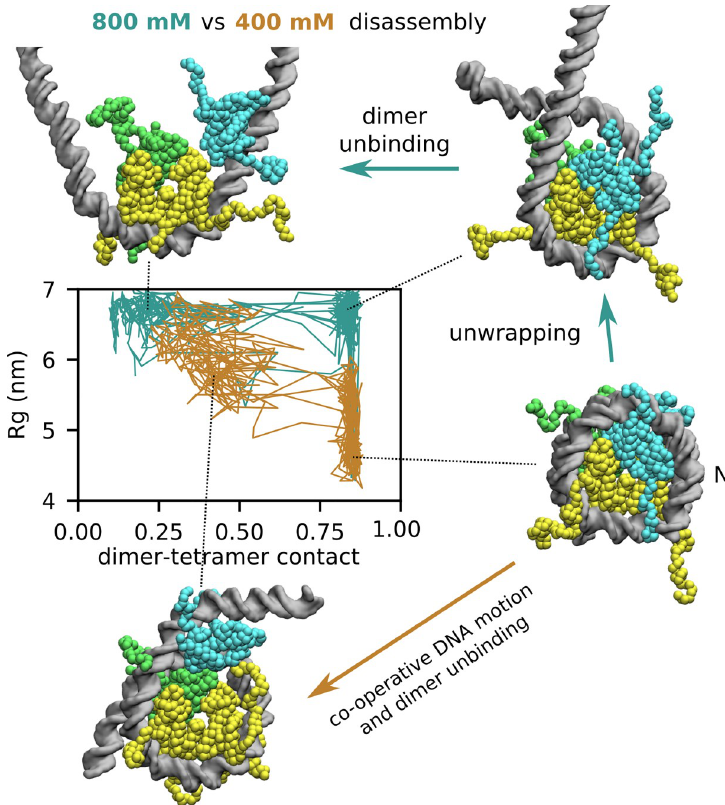
Fig 5. Salt-dependent nucleosome disassembly pathways. We project a set of representative disassembly trajectories along the DNA radius of gyration (Rg, the vertical axis) and a coordinate capturing dimer-tetramer contact formation (the horizontal axis, see Methods for the precise definition), at either 400 mM (in brown) or 800 mM salt (in cyan). While at intermediate salt concentration disassembly occurs in a single step involving dimer unbinding from the tetramer cooperatively with the stretching motion of DNA, at high salt concentration dimer unbinding follows a significant unwrapping of DNA from the histone octamer.